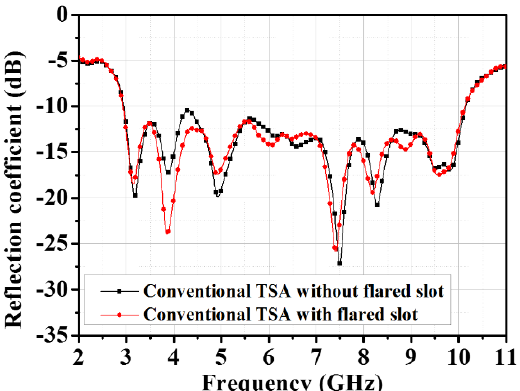
Figure 3. Reflection coefficients of conventional TSA with and without flared slots.